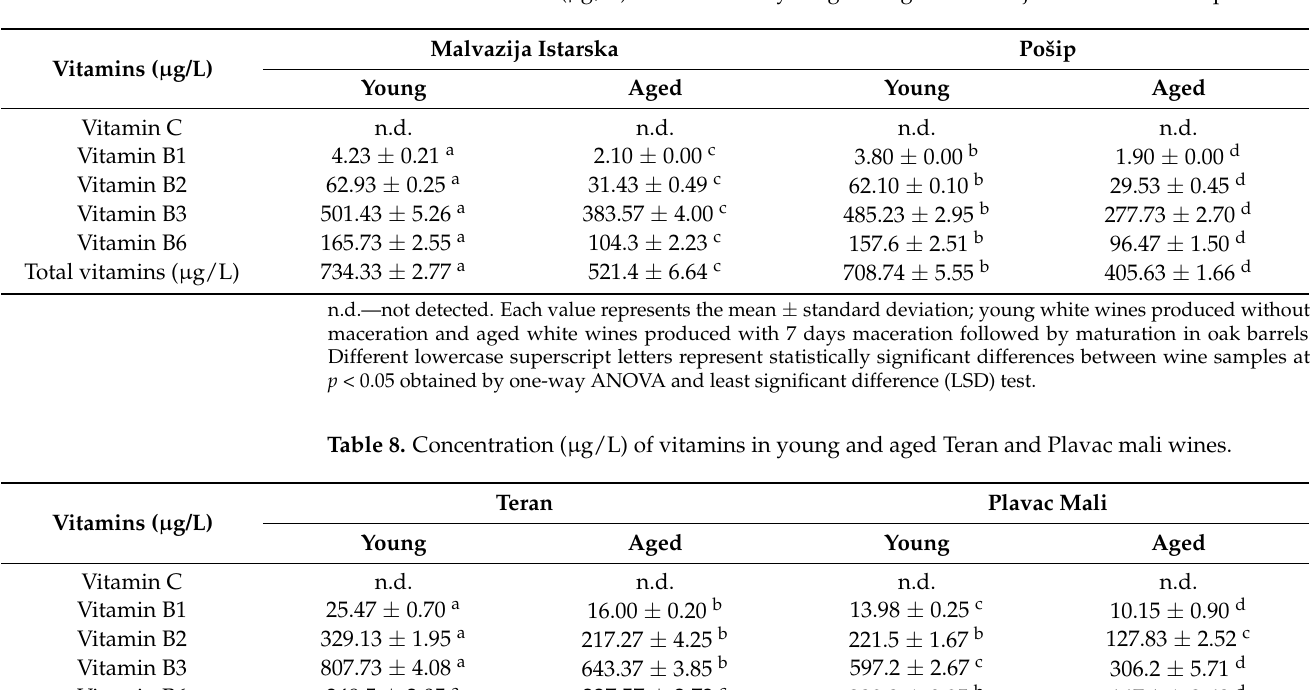
Table 7. Concentration ( µ g/L) of vitamins in young and aged Malvazija istarska and Pošip wine.